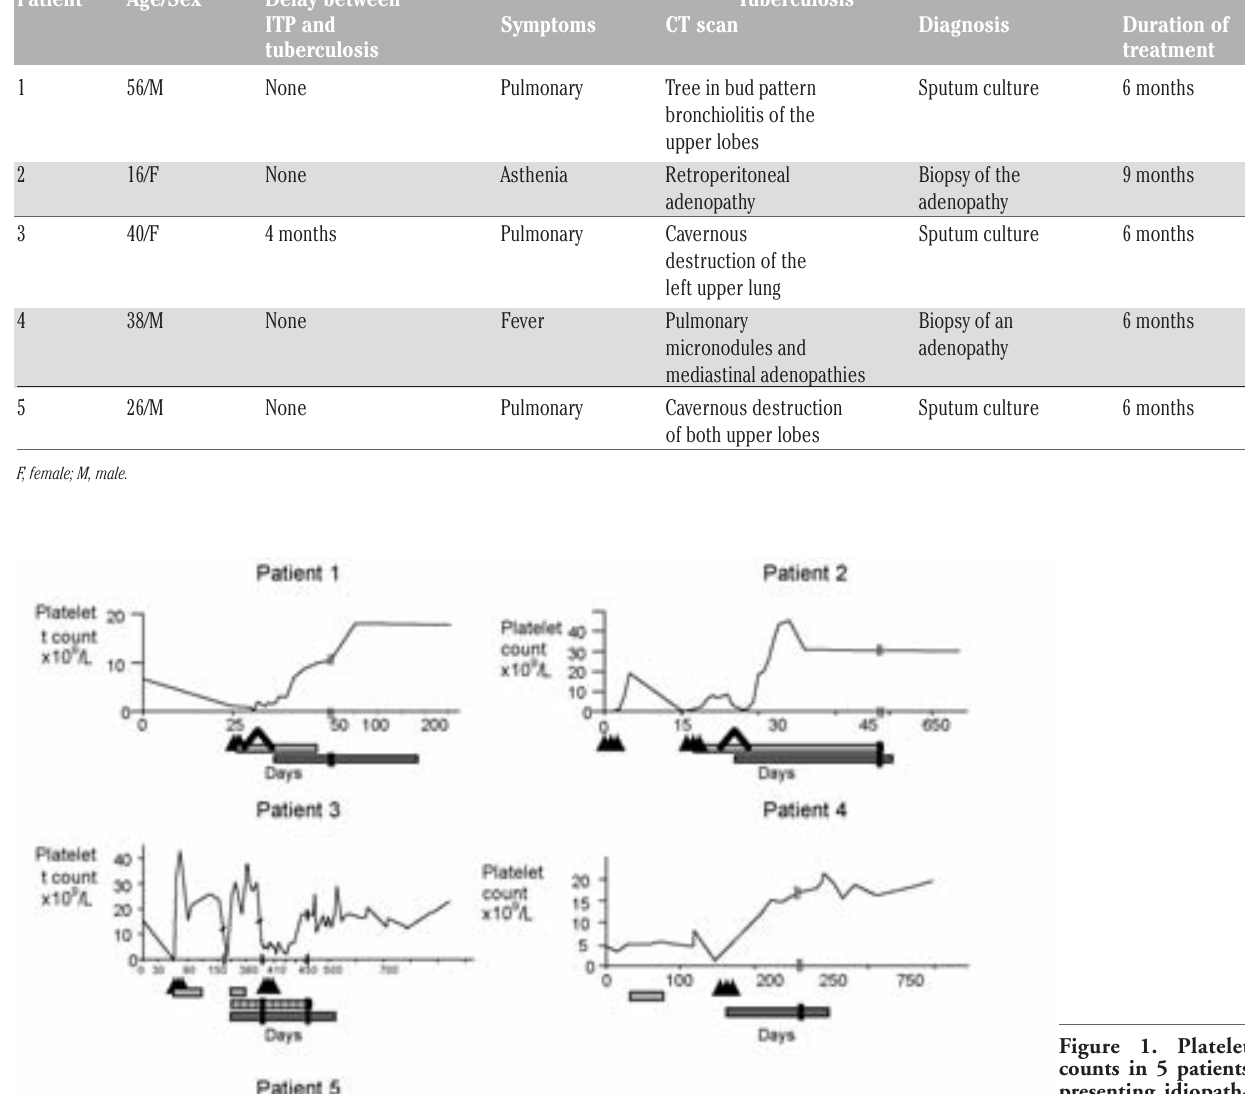
Figure 1. Platelet counts in 5